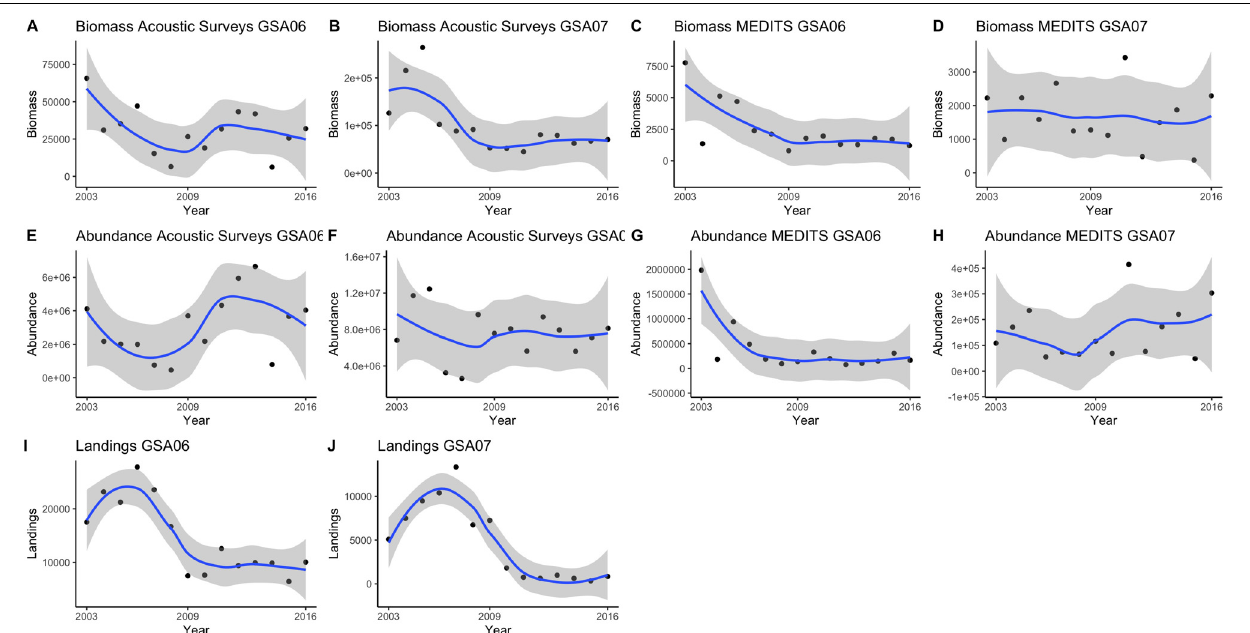
FIGURE 2 | Biomass (A–D) , abundance (E–H) , and landings (I,J) temporal trends from acoustic (ECOMED, PELMED, MEDIAS) and demersal (MEDITS) surveys and official countries landings for European sardine ( Sardina pilchardus ) in the Geographical Sub-Area 06 and 07 from 2003 to 2016.